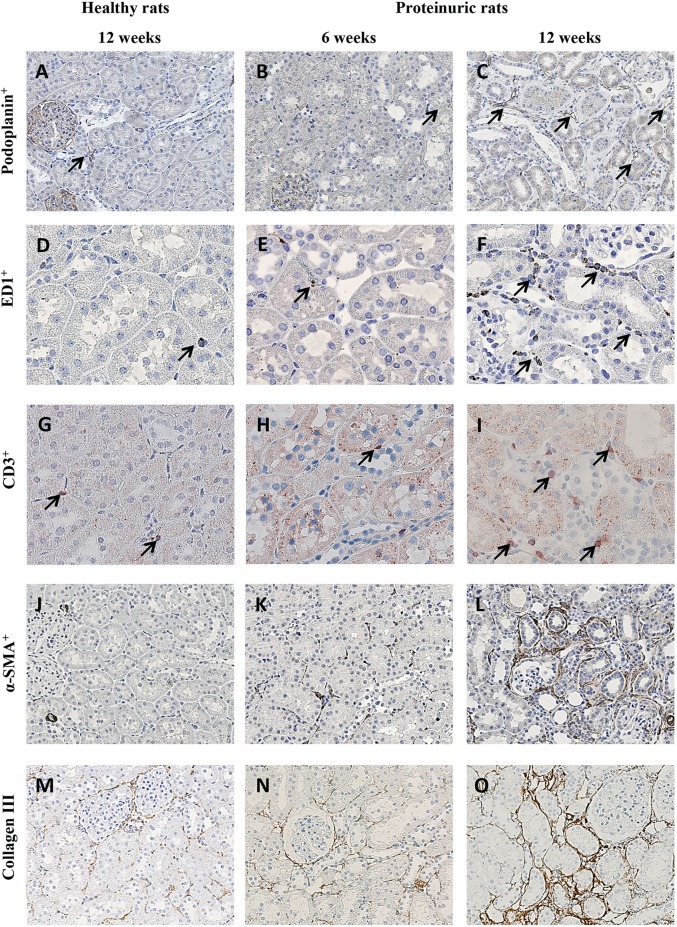
Development of renal lymphangiogenesis, inflammation and fibrosis in an adriamycin-induced proteinuria model. Representative photomicrographs show the differences in several markers in the kidneys of healthy rats, and in proteinuric rats at week 6 and week 12. (A-C) Podoplanin+ LVs (arrows); (D-F) ED1+ macrophages (arrows); (G-I) CD3+ T cells (arrows); (J-L) α-SMA+ myofibroblasts; (M-O) collagen III deposition. All markers were significantly increased at week 12 in proteinuric rats compared with the healthy controls at week 12 and the proteinuric rats at week 6. For quantification of these data at 12 weeks between proteinuric rats with and without treatment, see Figs 2, 4 and 6. Magnification: (A-C;J-O) 200×; (D-I) 400×.